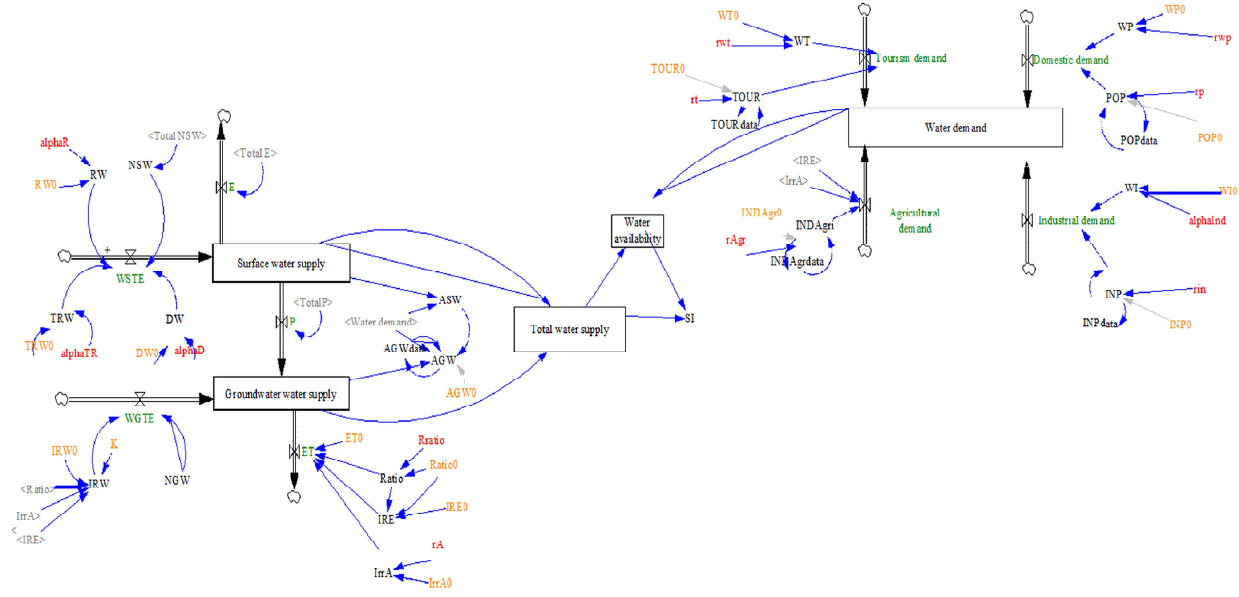
Figure 6. System Dynamics model simulation in the Souss-Massa basin.